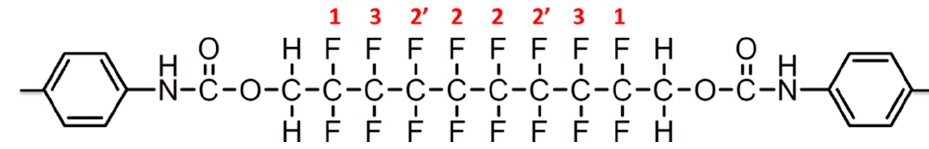
Figure 7. 1 H– 19 F COSY NMR of PFD/PU-03.